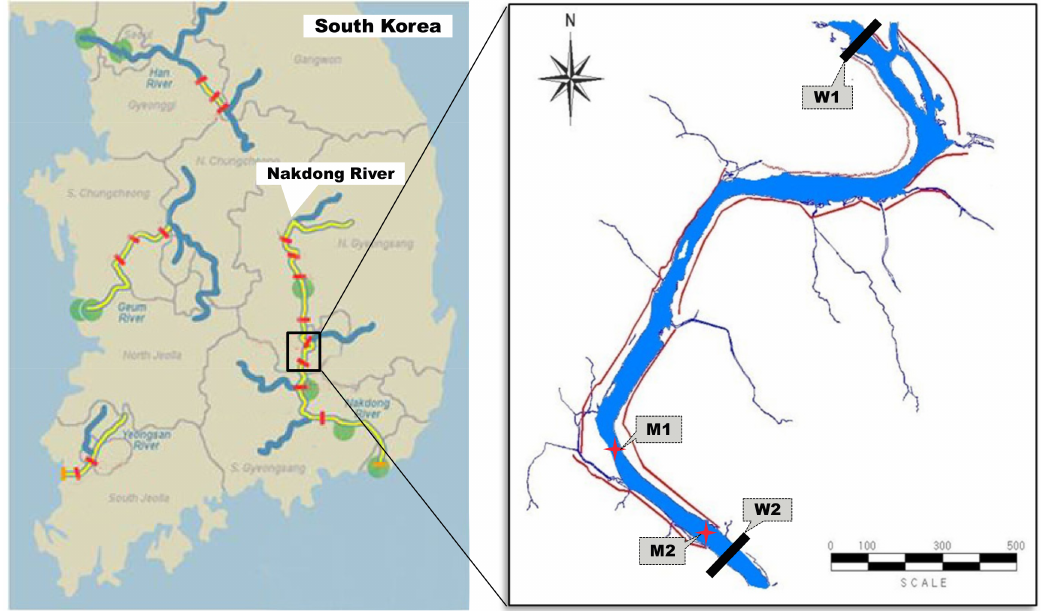
Figure 1. Map of the study site, including a section of the Nakdong River from the Goryeong weir to the Dalsung weir. The points on the map represent the weirs, the water quantity and quality monitoring stations, and the sampling